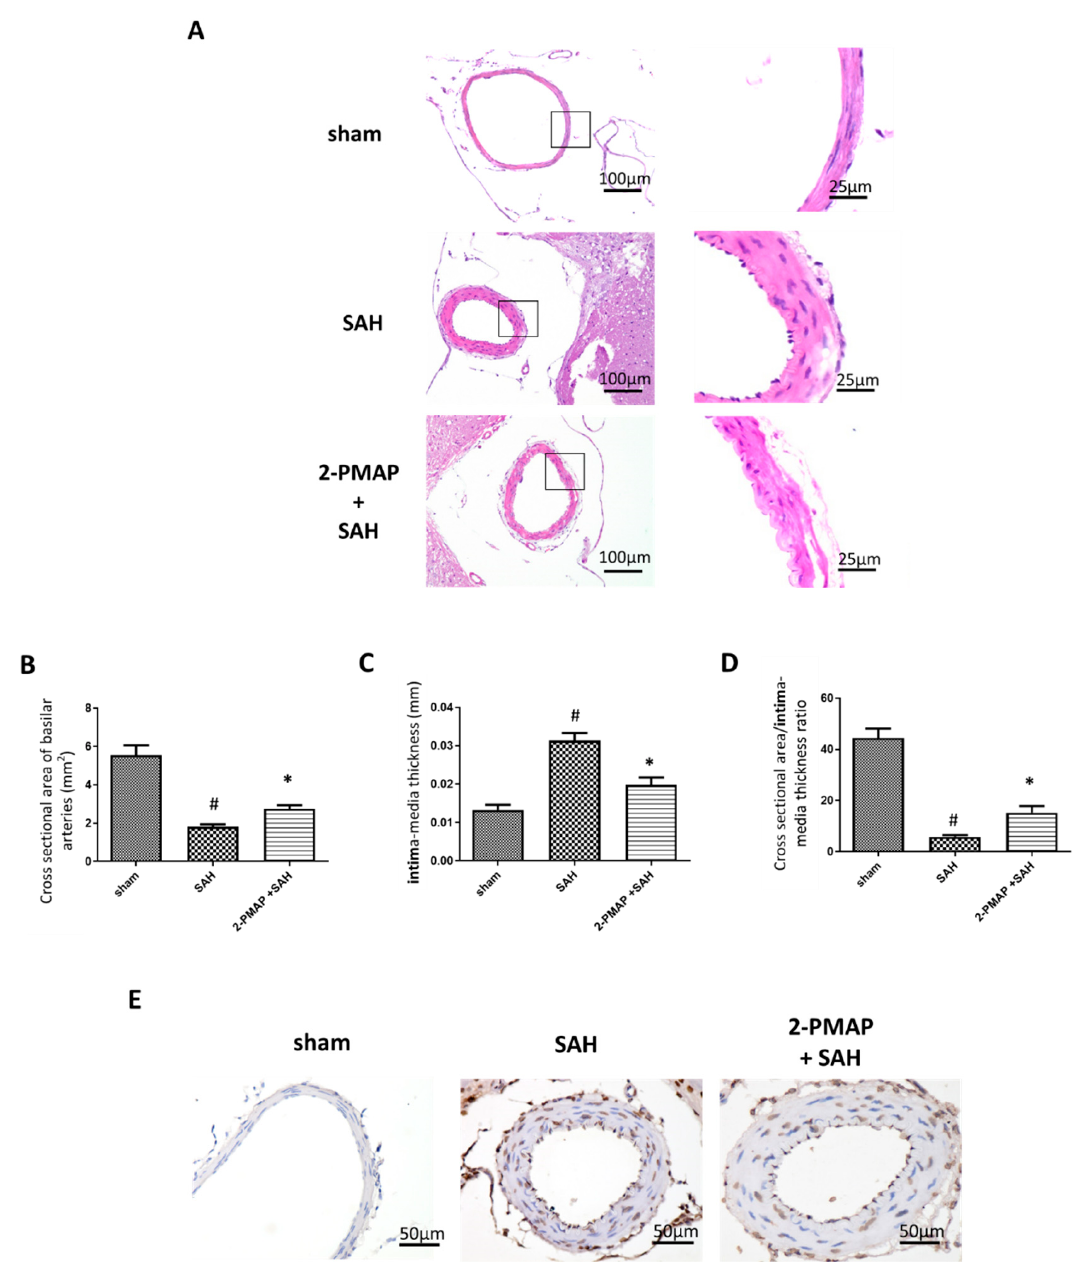
Figure 1. 2-PMAP reduced vasospasm severity in SAH rats. ( A ) Representative cross-sections of the BA in SAH rats by H&E stain. Left panels have scale bars of 100 µm. Right panels are high-power views of tissues, with scale bars of 25 µm. ( B – D ) Quantification of the ( B ) cross-sectional areas of the internal lumen, ( C ) the BA wall intima-media thickness and ( D ) the ratio of the cross-sectional area to the wall intima-media thickness. Data are shown as mean + SD ( n = 6 for each group); *, p < 0.05, significantly different from the SAH group. #, p < 0.05, significantly different from the sham group. ( E ) TUNEL staining was utilized to detect apoptotic endothelial cells. Scale bars: 50 µm. No apoptotic endothelial cells of the BA were observed in sham rats. Increased apoptotic endothelial cells were observed in SAH rats, which was reduced markedly by 2-PMAP (arrows).